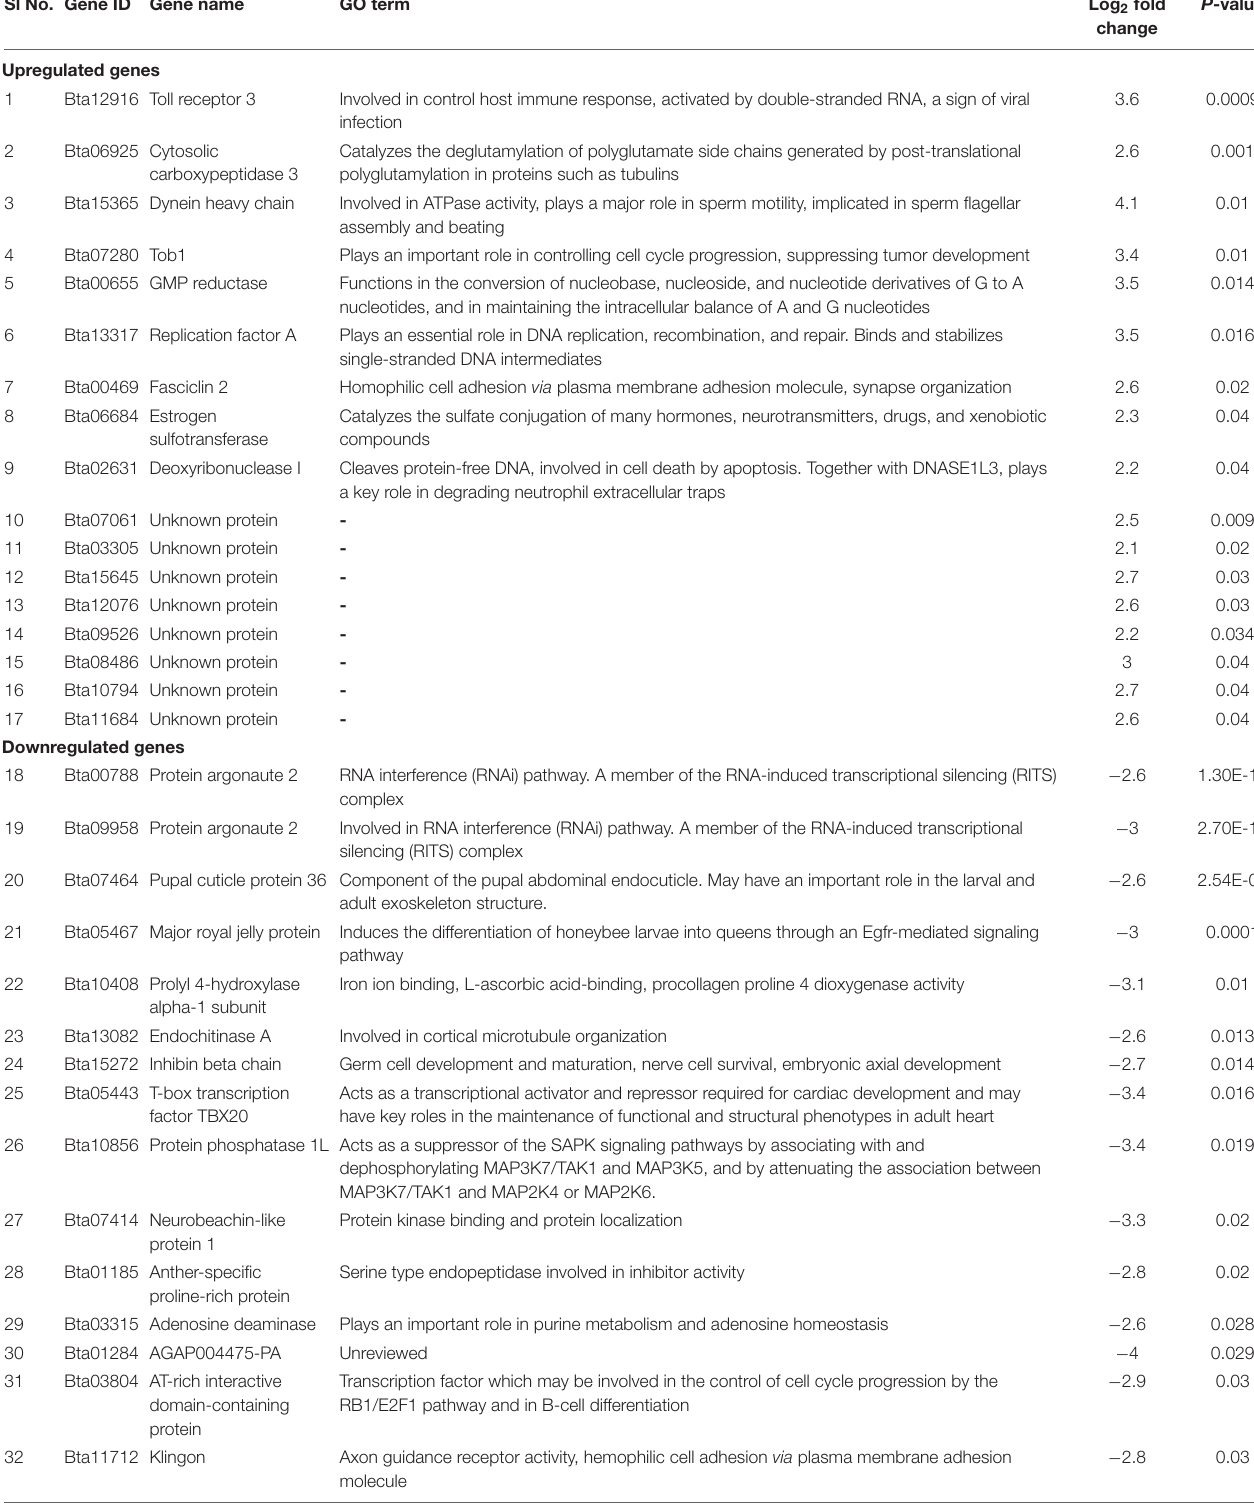
TABLE 2 | Differentially expressed upregulated and downregulated genes of B. tabaci Asia II 1 in response to ChiLCV infection. Sl No. Gene ID Gene